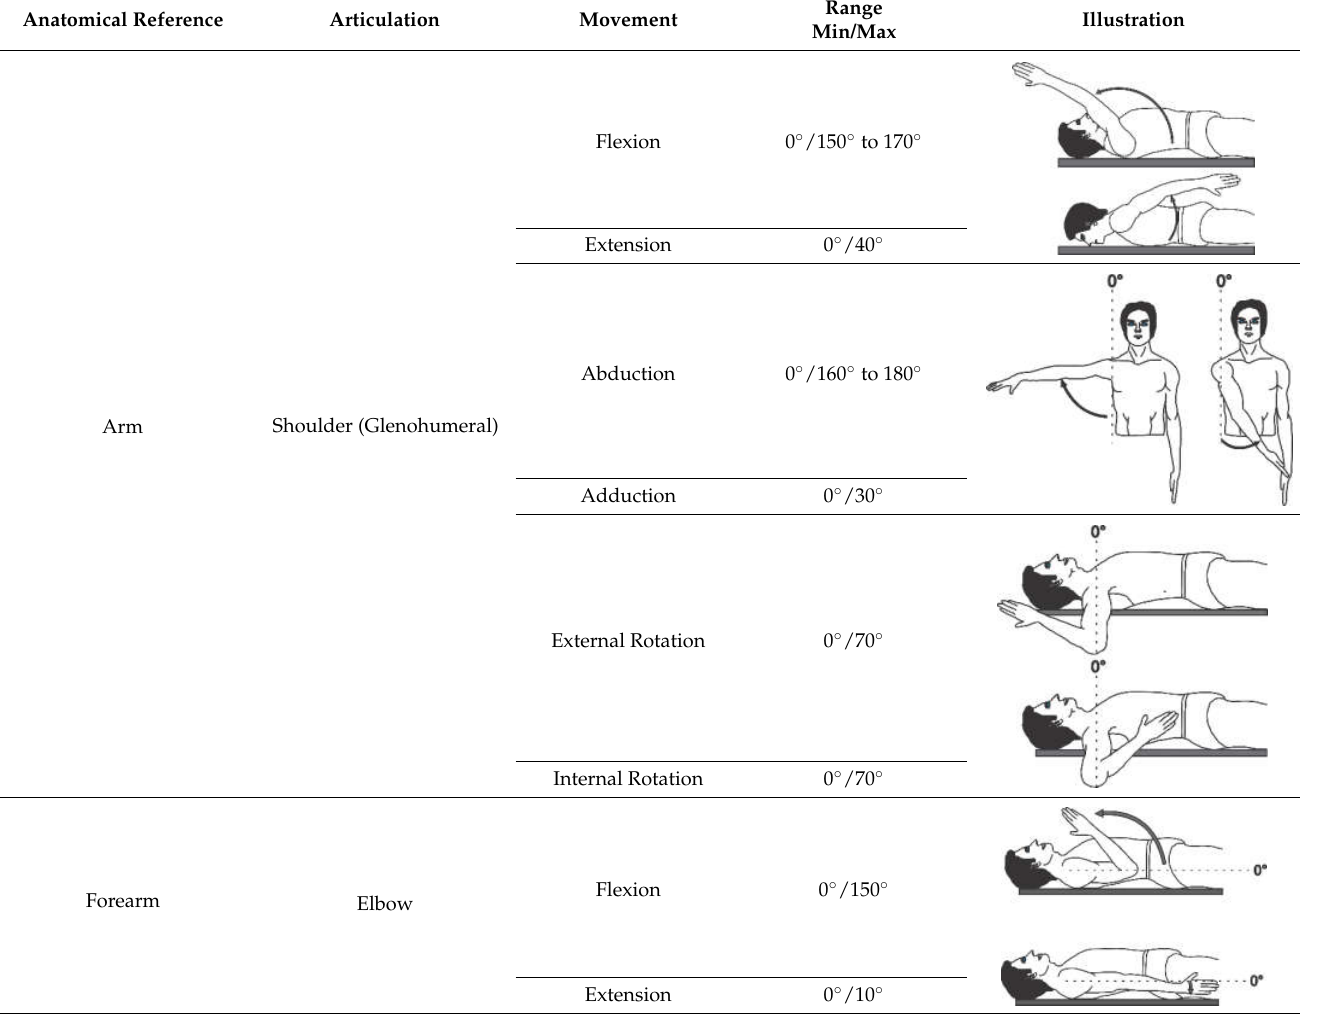
Table 1. Normal angular range of motion in the upper extremities